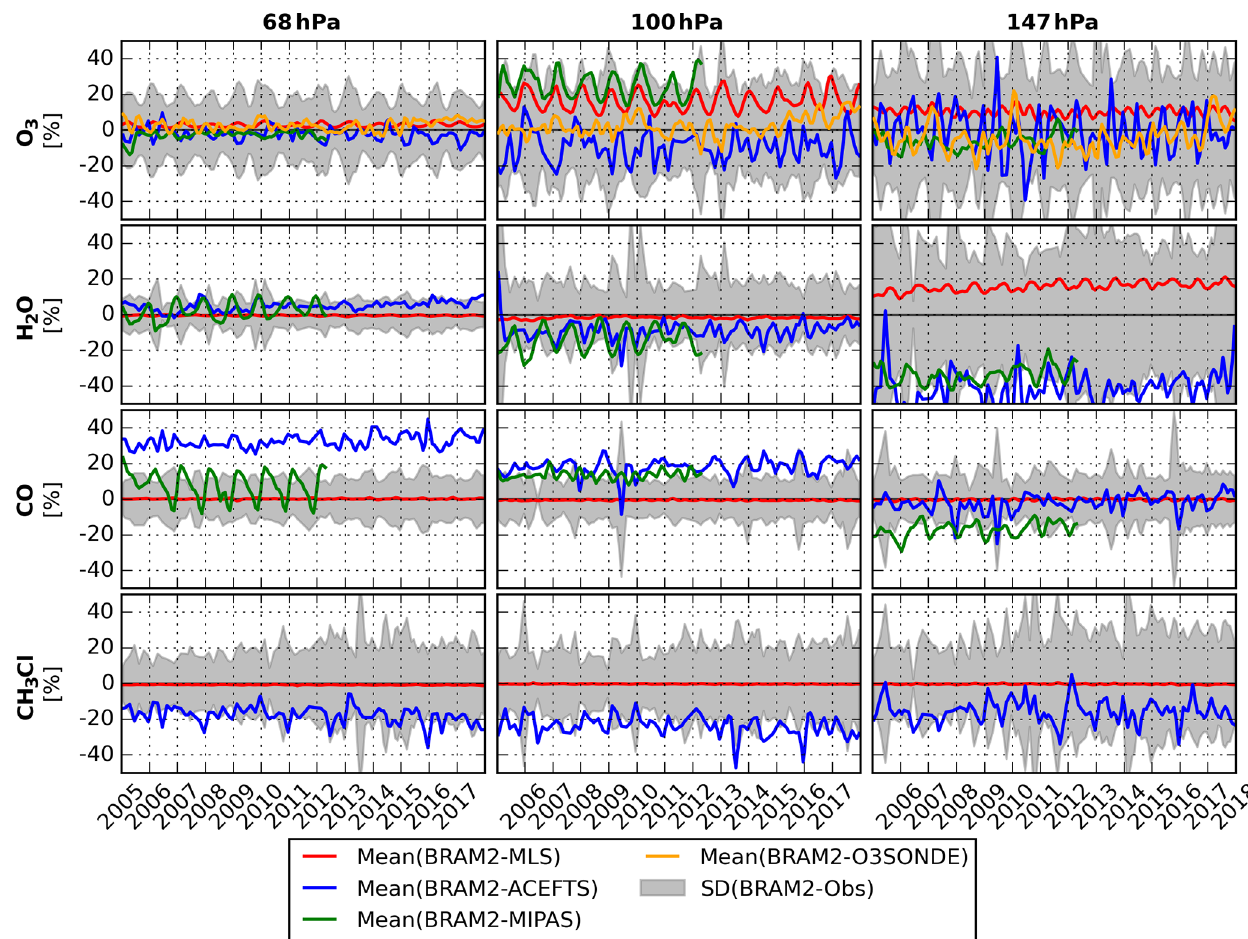
Figure 13. Time series of the monthly mean differences between BRAM2 and the different observational datasets in the TTL (30 ◦ S–30 ◦ N) at three pressure levels (from left to right: 68, 100 and 147hPa) and for (top to bottom) O 3 , H 2 O, CO and CH 3 Cl. Values are in percent. The grey shaded area represents the standard deviation of the differences between BRAM2 and ACE-FTS except for O 3 where ozonesonde data are